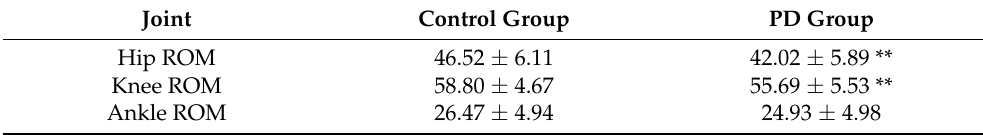
Table 5. Dynamic range of motion during gait (in degrees). Values are expressed as mean ±